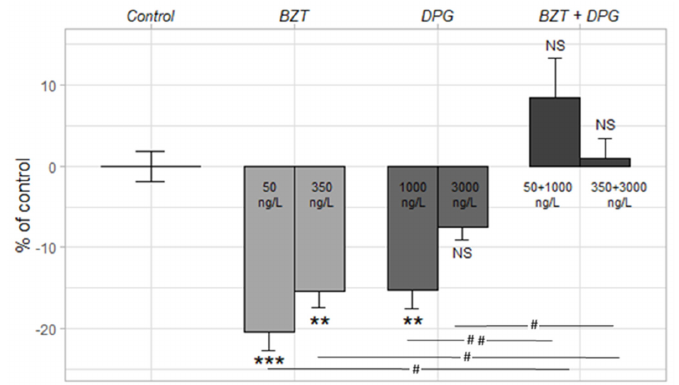
Figure 7. Activity (% of control) of 6 dpf old zebrafish larvae exposed to BZT and DPG in chronic exposure (dark period). Control = E3 solution, number of larvae = 12 per condition; NS = not significant; *: difference compared to control. # = p -value < 0.05; **, ## = p -value < 0.01, *** = p -value < 0.001 (non-parametric Kruskal–Wallis test). Error bars represent the standard error. No significant mortality nor deformities were observed in these two conditions. In acute exposure to BZT, DPG, or to the two mixes, no significant differences were observed at all concentrations tested in dark and light conditions compared to controls (data not shown). In chronic exposure, BZT significantly inhibited larvae activity at 50 and 350 ng/L in dark periods, reaching 15 to 20% less distance moved compared to control, with no sig- nificant difference between the two concentrations. Similarly, DPG at 1000 ng/L inhibited the distance moved by the larvae by 15%, while the highest concentration, unexpectedly, failed to do so significantly. The difference between the effects of these two concentrations